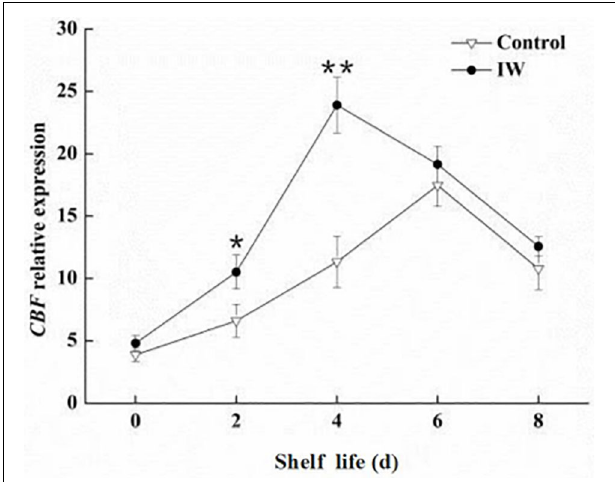
FIGURE 6 | Effect of intermittent warming on the gene expression of VcCBF of blueberry fruit at room temperature after a 30-day refrigeration. Mean ± SE of three replicate experiments are shown. Asterisks indicate significant differences between control and IW-treated fruit (* p < 0.05, ** p <